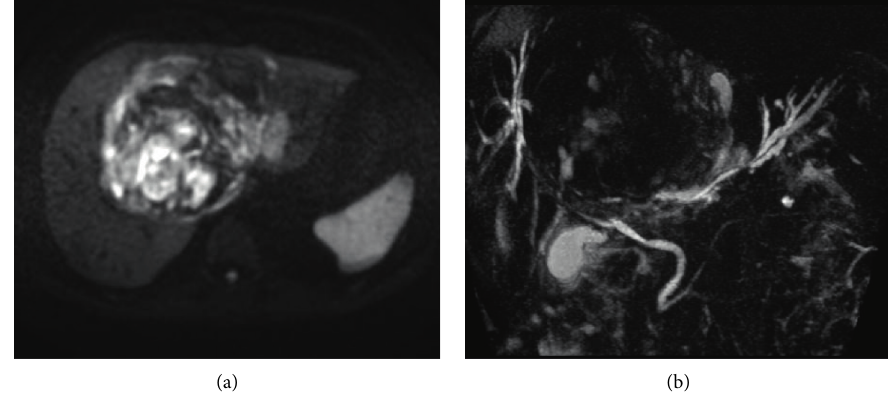
Figure 2: (a) Diffusion-weighted MRI images showing multiple tumors with diffusion decrease in the left lobe of the liver. (b) On MRCP, the intrahepatic bile duct was observed to be markedly compressed by bleeding in the hilum of the